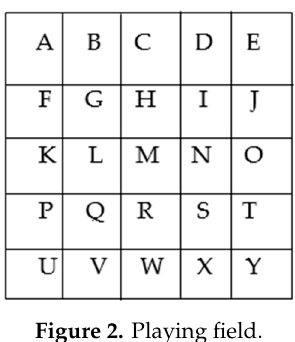
Figure 2. Playing Figure 2. Playing field.